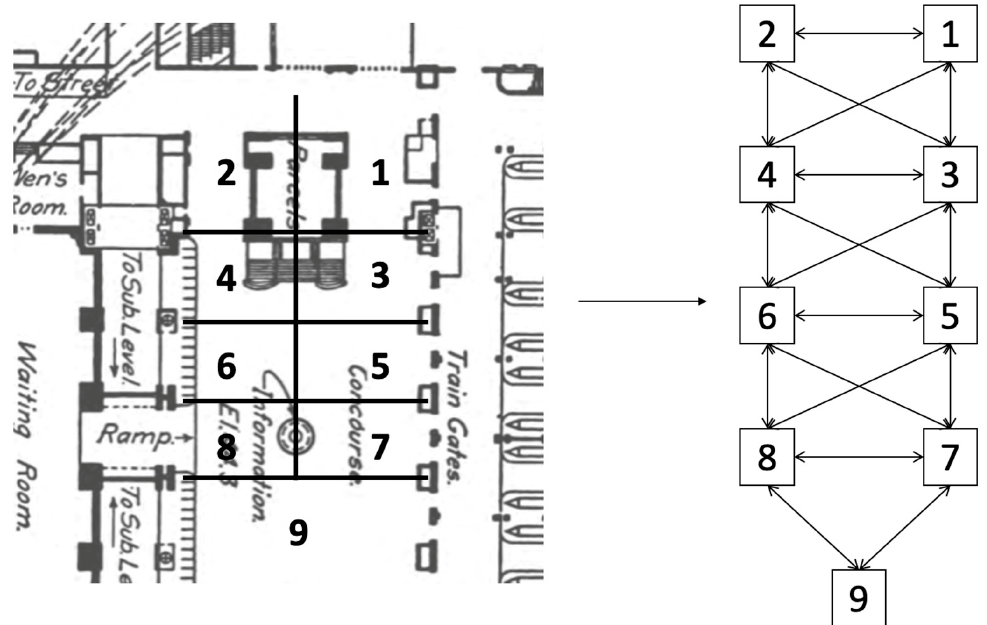
Figure 4. Egress region division and CMGraph formulation of the Grand Central Station. Nine egress regions were manually identified. Grand Central Station floorplan adopted from [19].